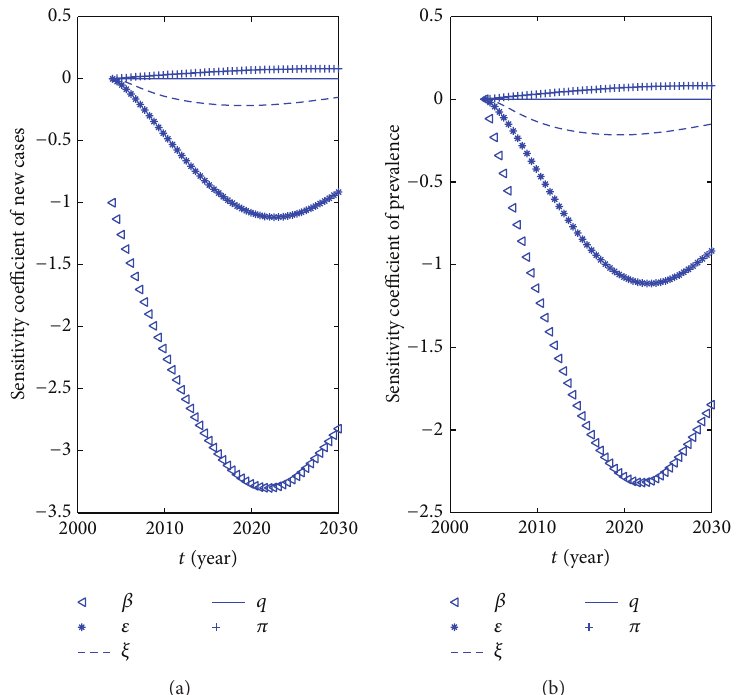
Figure 4: Sensitivity coefficients of new cases (a) and prevalence (b) on 𝛽 , 𝜖 , 𝜉 , 𝑞 , and Π over time 𝑡 . All other parameters are shown in Table